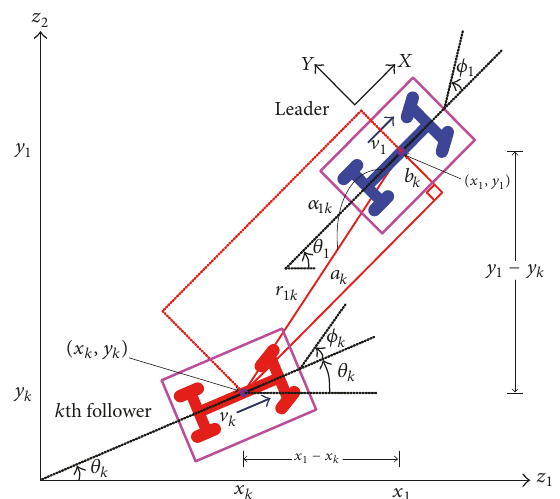
Figure 2: The proposed scheme utilizing a rotation of axes with the body frame fixed at the leader